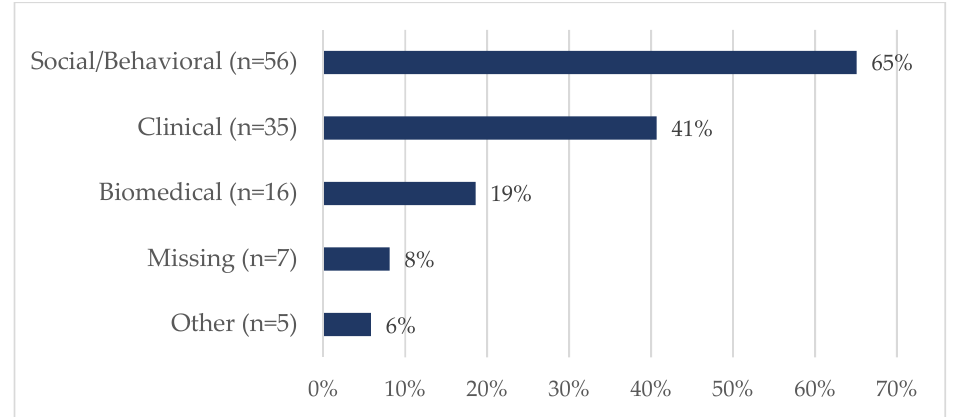
Figure 6. RCMI project content area for TAG-SC support (N = 86 *) during Phase II: Pilot Year and Phase III: Year 1 of TAG-SC. * Respondents could select more than one area. Thus the number of responses is greater than the number of respondents